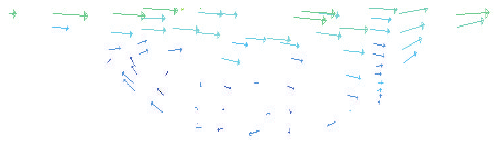
Figure 13: Velocity vector within dimple bionic nonsmooth